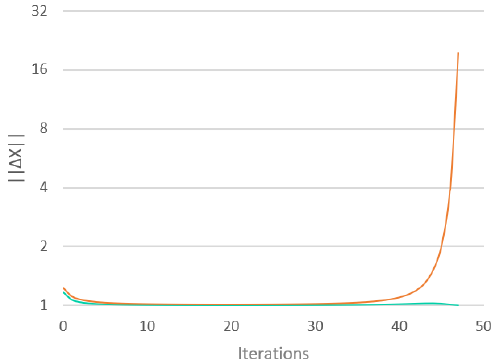
Figure 21: Minimal and Maximum resultant stress per iteration, for h = 1.34 r